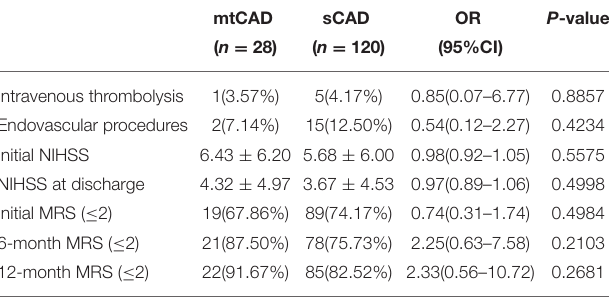
TABLE 3 | Intervention and outcomes.